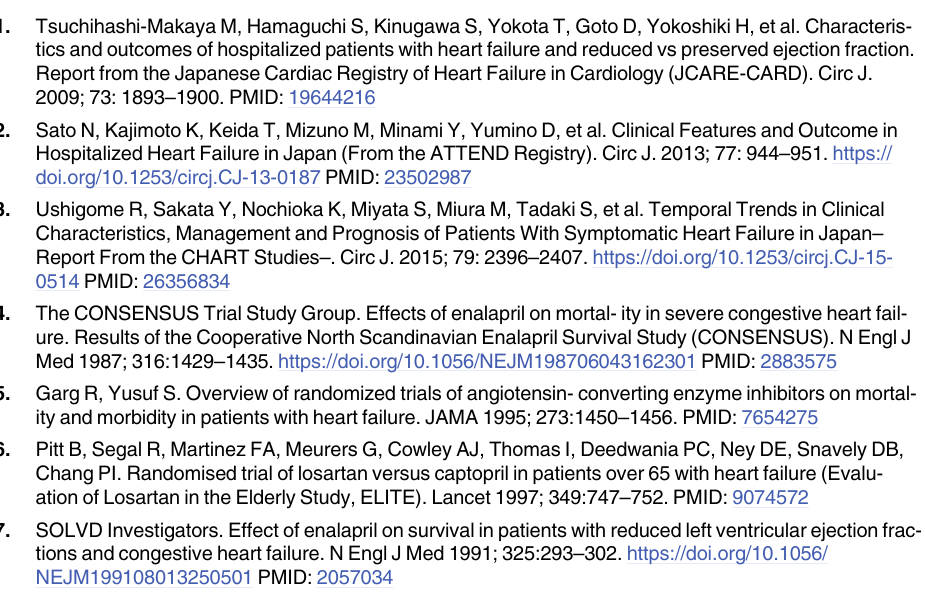
S1 Table. Characteristics of patients for each risk group. Values are mean ± SD, %, or median (quartile 1–quartile 4). � Significant p